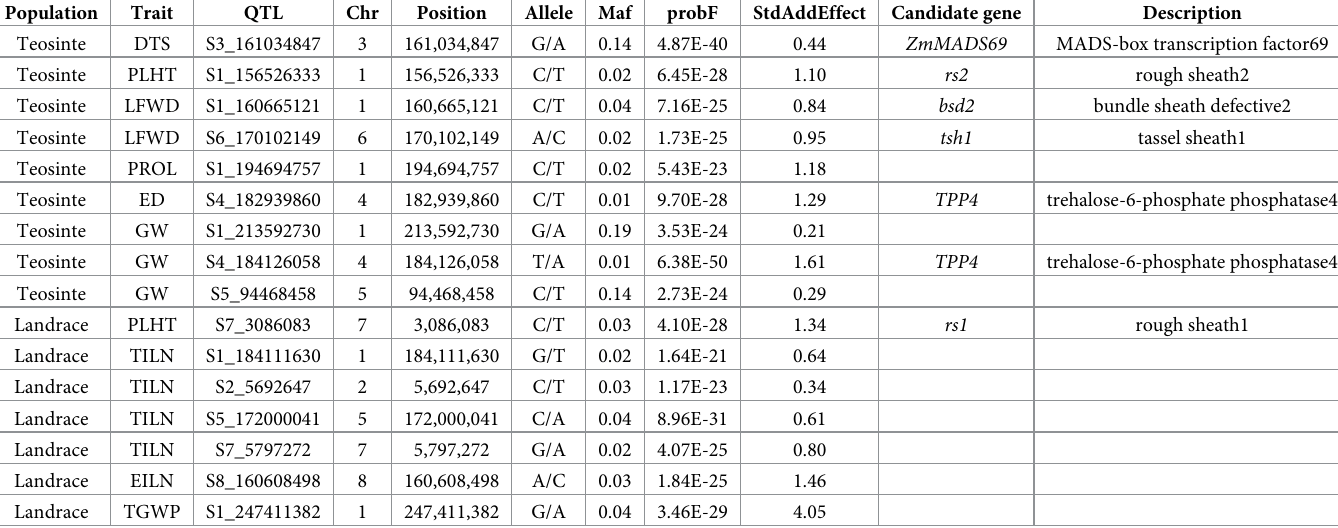
Table 2. Candidate genes under P <